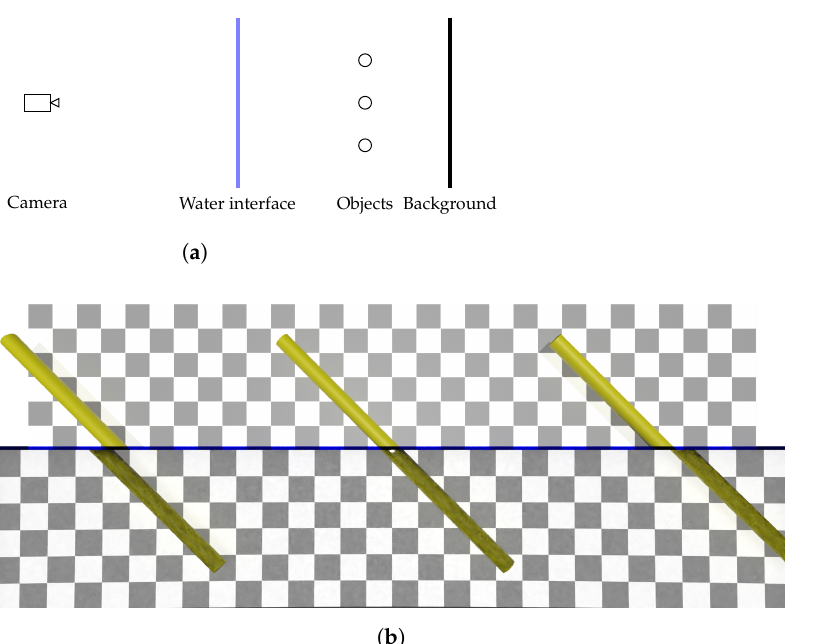
Figure 6. Example of light refraction occurring for a half-filled tank of water (IOR = 1.333). ( a ) Setup and ( b ) render. The blue line indicates the interface. For visualisation purposes, the effect is exaggerated by using a relatively low focal length (20 mm); also note the effect of refraction on the light intensity in the water-filled